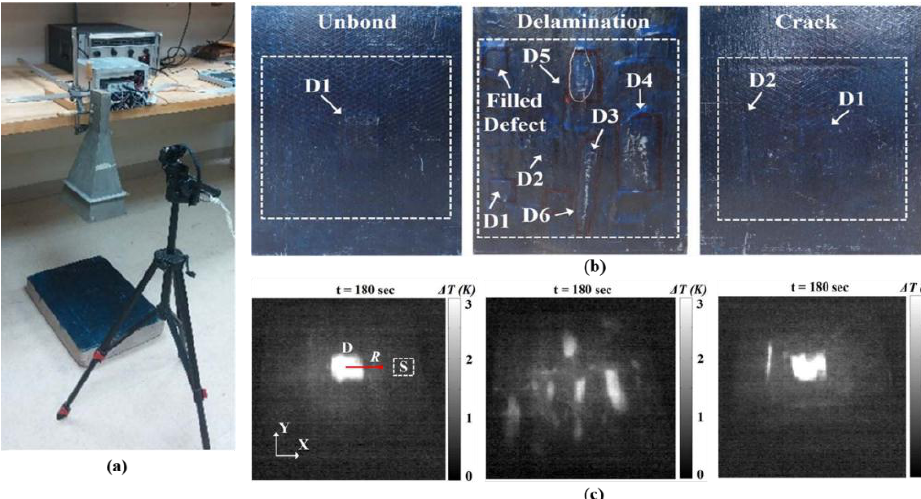
Figure 17. MWT measurement setup ( a ), samples under test ( b ) and thermal profiles for samples under test ( c ) [70]. Reprinted/reproduced with permission from IEEE.